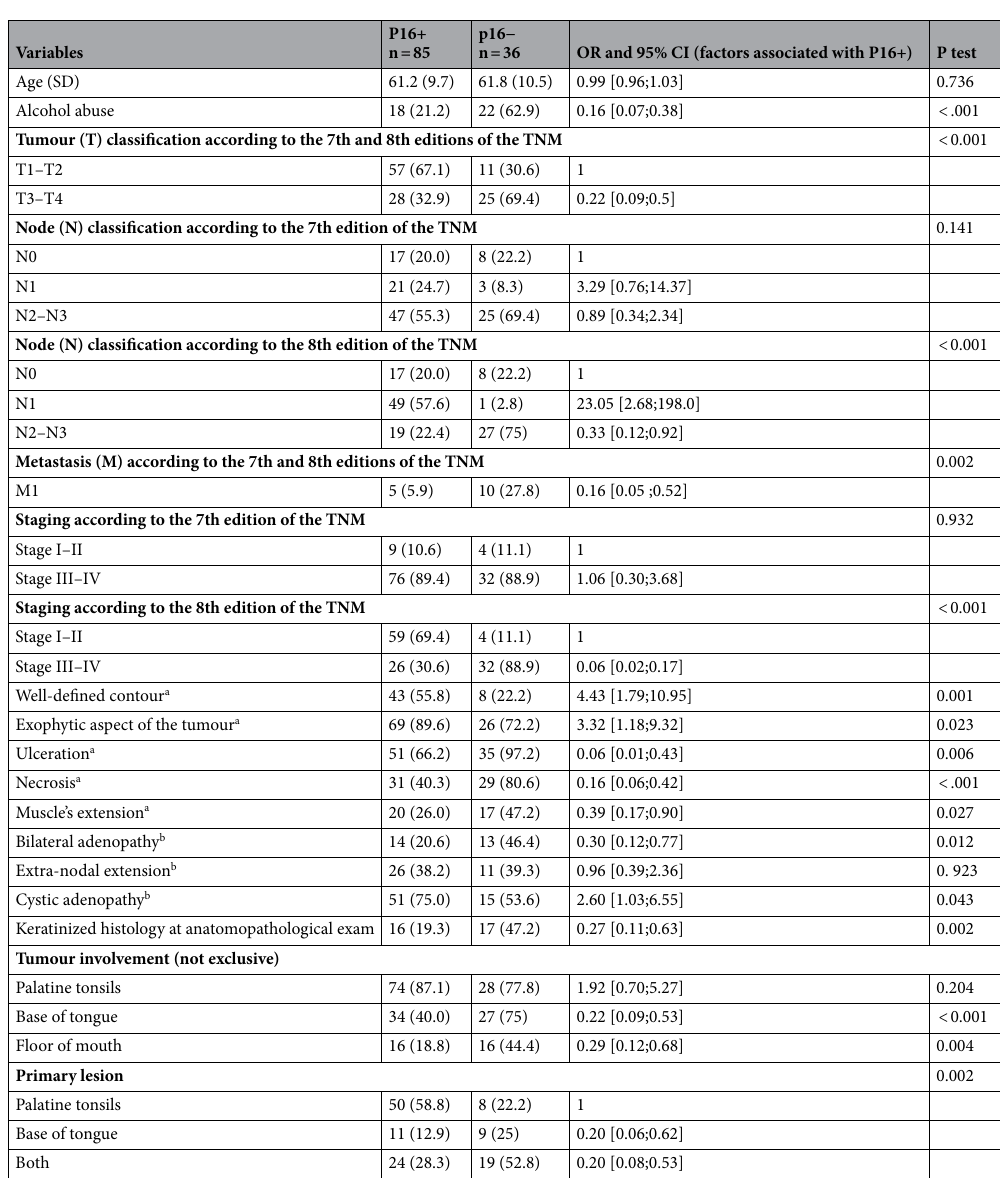
Table 2. Comparison of data from P16+ and p16− patients (n = 121). Variables are displayed as number (%) or mean (standard deviation). a Data missing for 8 patients owing to no visible tumour (not visible clinically or on CT; pT1 on anatomopathological exam). b Data missing for 25 patients owing to no visible adenopathy